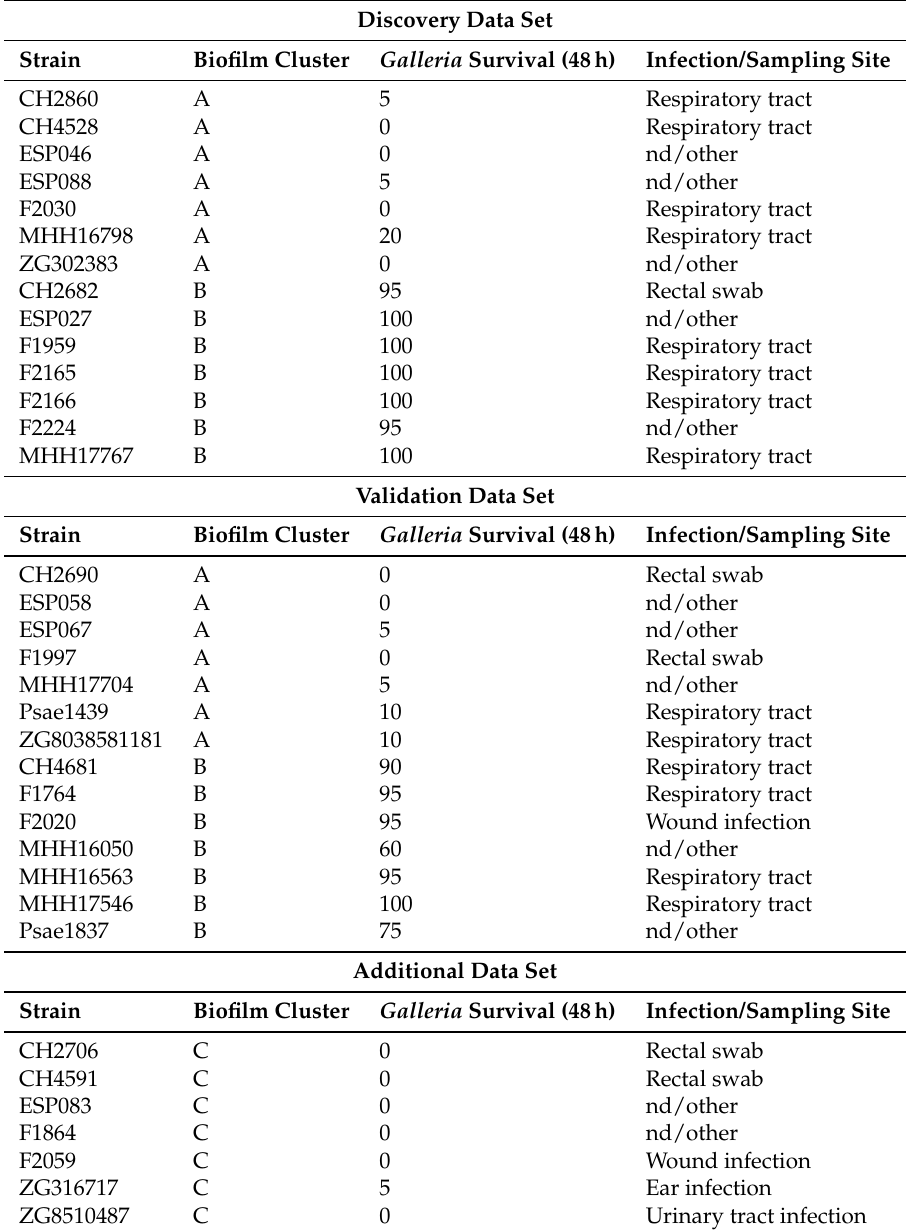
Table 1. Strains used in this study. Strains are listed by their identifier in the Bactome data base [35]. The biofilm cluster corresponds to the biofilm morphology [15] and the survival rate in a Galleria mellonella infection model (according to [34]) is given in percent survival after 48h. The infection or sampling site is indicated if available. nd—not